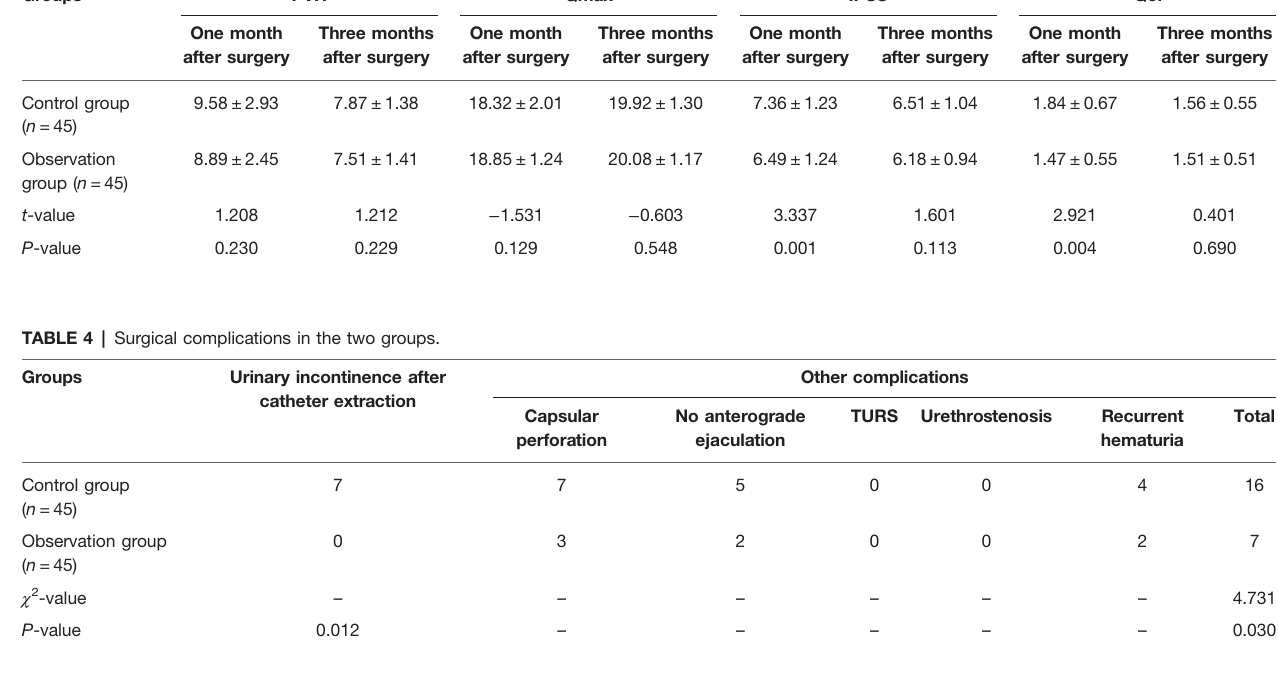
TABLE 3 | Postoperative re-examination and follow-up results. Groups